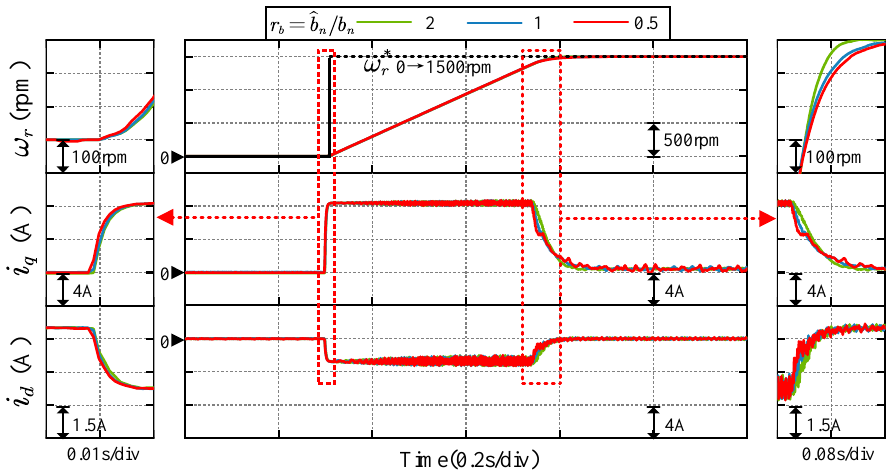
Figure 16. Experimental results of the speed response with step speed reference from 0 rpm to 1500 rpm under different r b , where ω 0 n = 120 π , k n = 10 π , r b = [ 0.5, 1, 2 ] . Figure 17 shows the experimental results of the speed response with sinusoidal speed reference. Three groups of experiment results with different r b are presented and compared, where ω 0 n = 120 π , k n = 80 π , r b = [ 0.5, 1, 2 ] . It can be seen that r b = 2 leads to amplitude amplification and phase delay, while r b = 0.5 leads to amplitude attenuation and phase advance. This is because the 15 Hz sinusoidal reference lies in the middle-frequency range in Figure 5. As for the high-frequency range, the corresponding experiments are unable to conduct due to the current limitation of the power converter.